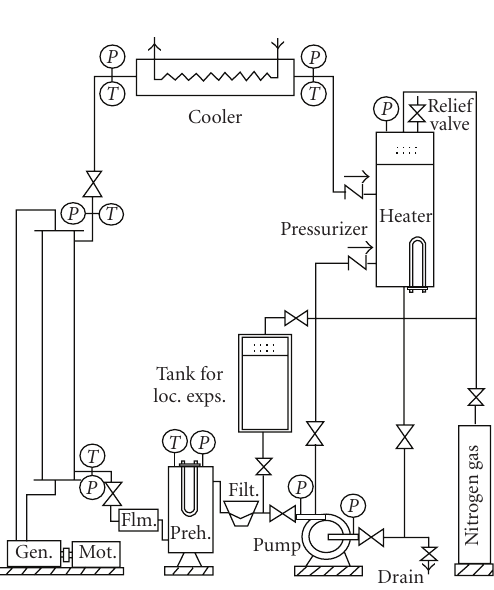
Figure 2: Standard IC of an SBWR.